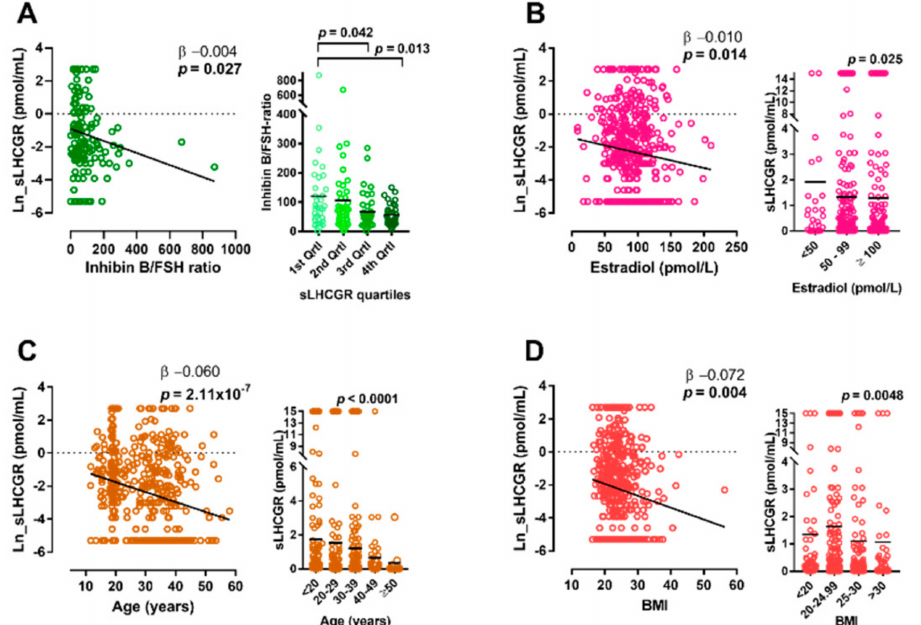
Figure 3. Association between sLHCGR in serum and reproductive hormones, age and BMI in adult men. ( A ): sLHCGR and gonadal function in 148 young healthy men. A1: Linear regression shows an inverse association between sLHCGR and Inhibin B/FSH-ratio. A2: Serum sLHCGR stratified into quartiles and inhibin B/FSH-ratio, bar shows mean, p -values adjusted for multiple comparisons using Dunn-Bonferroni post hoc test. ( B – D ): Serum sLHCGR in a pooled analysis of all men with normal sex-chromosomes after pubertal onset. B1: Linear regression showing an inverse association between sLHCGR and estradiol. B2: sLHCGR in all men stratified into three groups based on baseline estradiol, bar shows mean, p -value from Kruskal Wallis. C1: Linear regression showing an inverse association between sLHCGR and age. C2: sLHCGR in all men stratified into five groups based on age, bar shows mean, p -value from Kruskal Wallis. D1: Linear regression showing an inverse association between sLHCGR and BMI. D2: sLHCGR in all men stratified into four groups based on BMI, bar shows mean, p -value from Kruskal